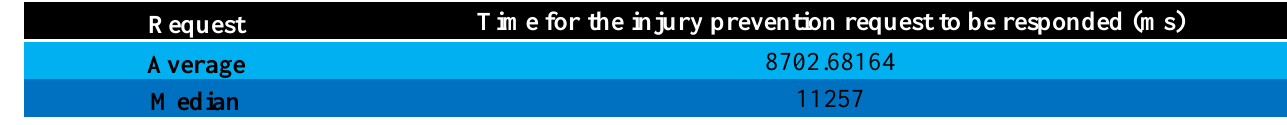
Table 6. Most significant measures obtained for injury prevention